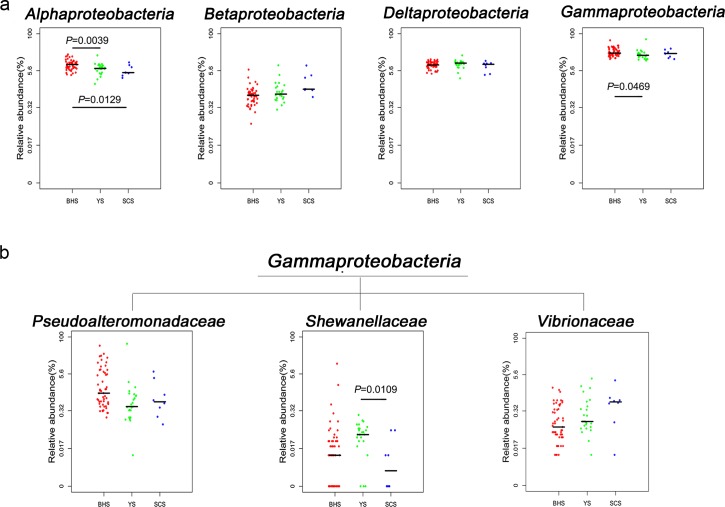
(a) Dot plots of relative abundance. The dot plots show the relative abundance of the four classes of Proteobacteria. (b) Dot plots of the relative abundances of the four genera of Gammaproteobacteria in the three seas. The bar represents the median.